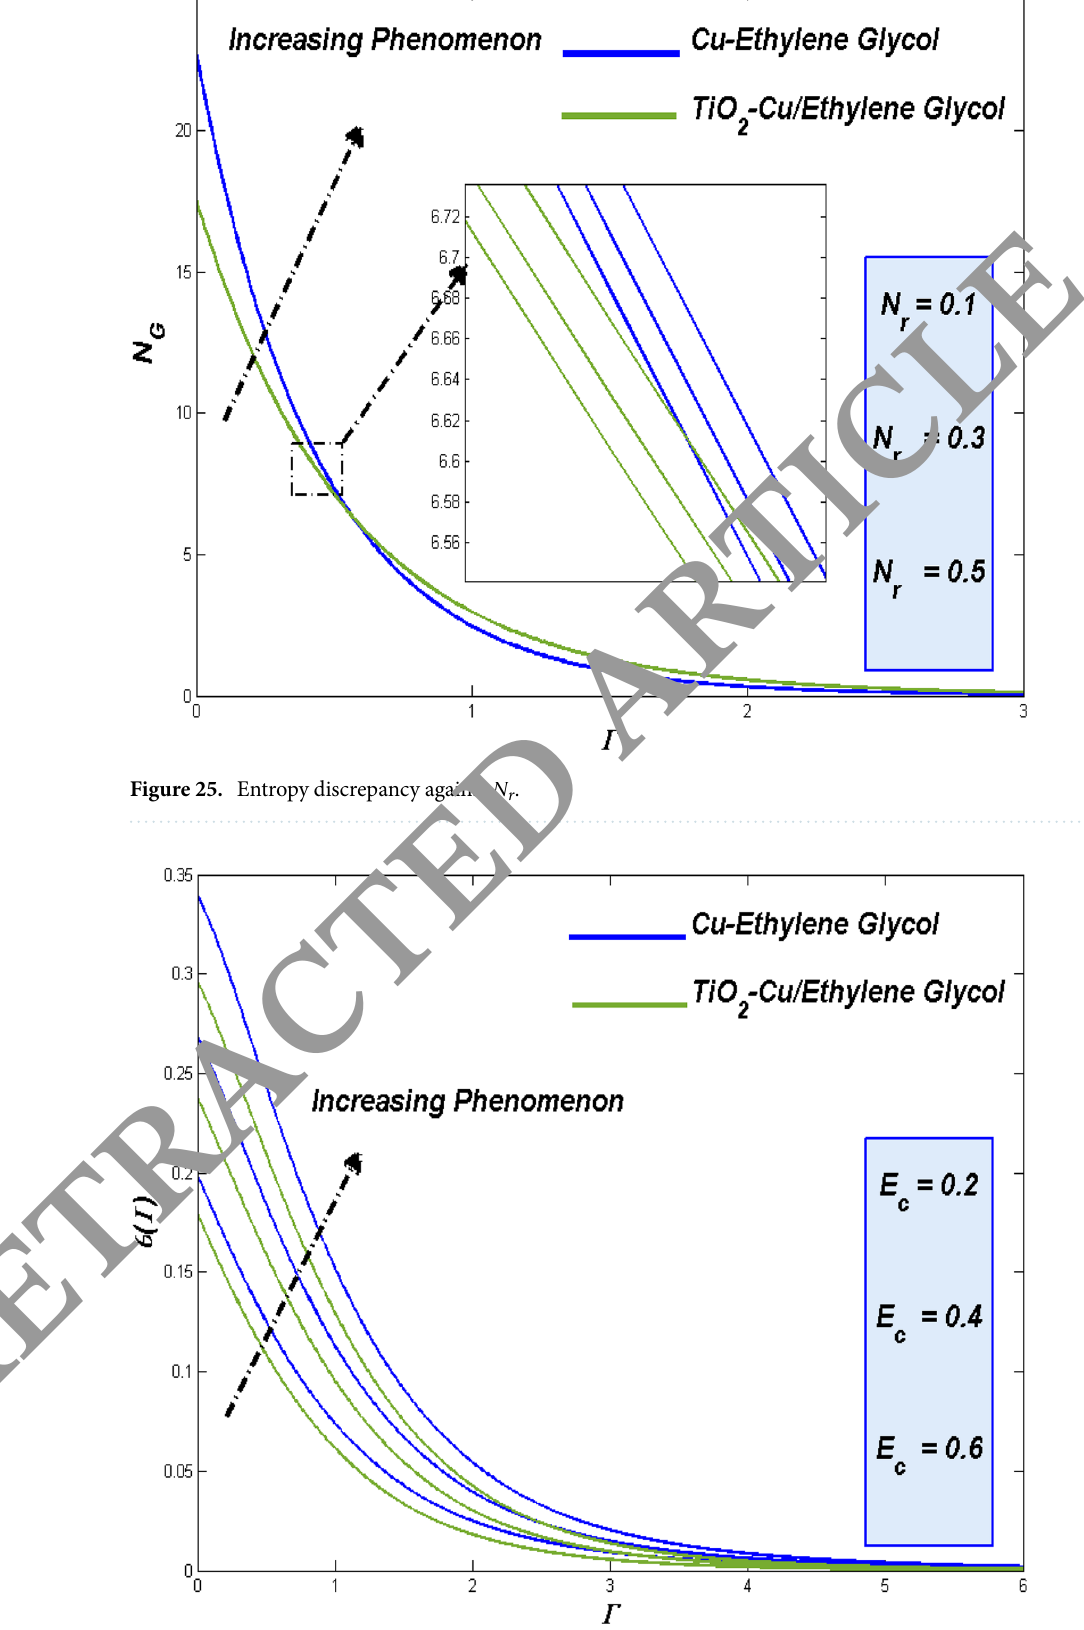
Figure 26. Temperature discrepancy against E c